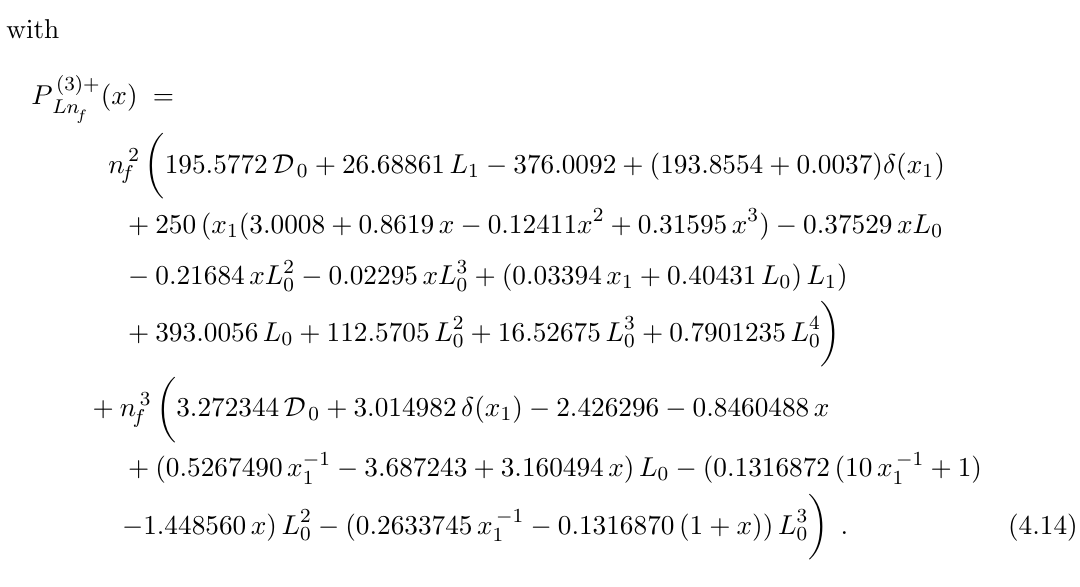
0 : 3. The large relative ’ x ) 0 : 005. (cid:0) ’